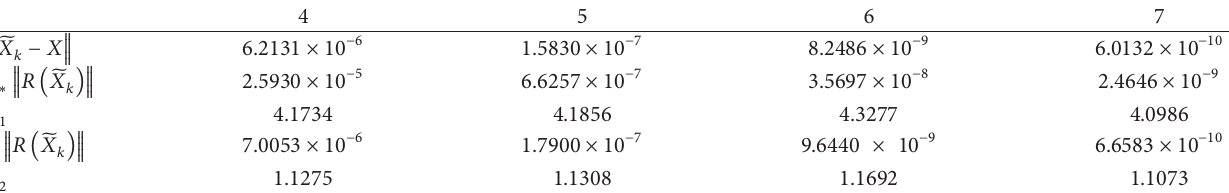
Table 3: Results for Example 2 with different values of k